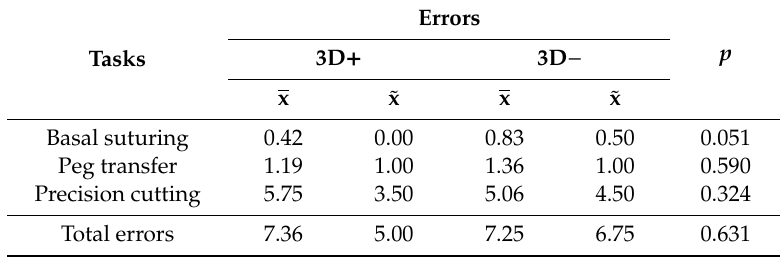
Table 2. Errors of participants using the two systems, 3D + with glasses and 3D − without glasses, for each task.